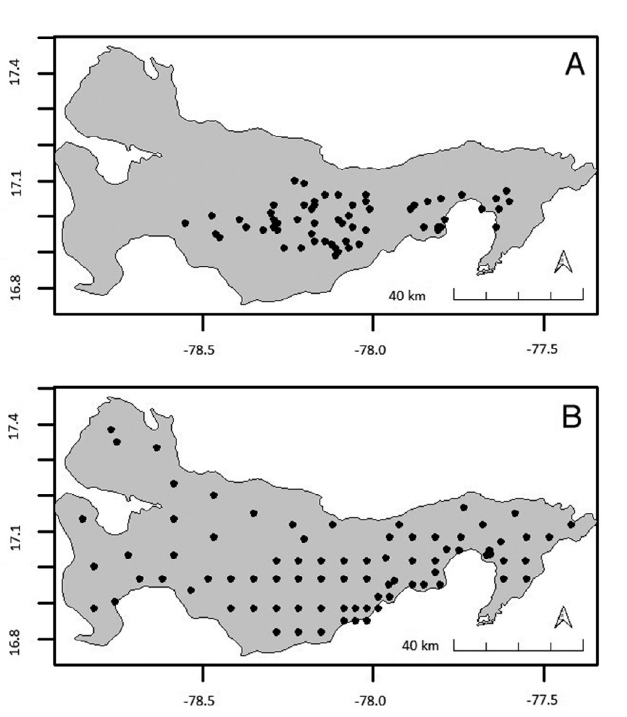
Fig. 2. – Sampling designs for the 2007 (A) and the 2015 and 2018 surveys